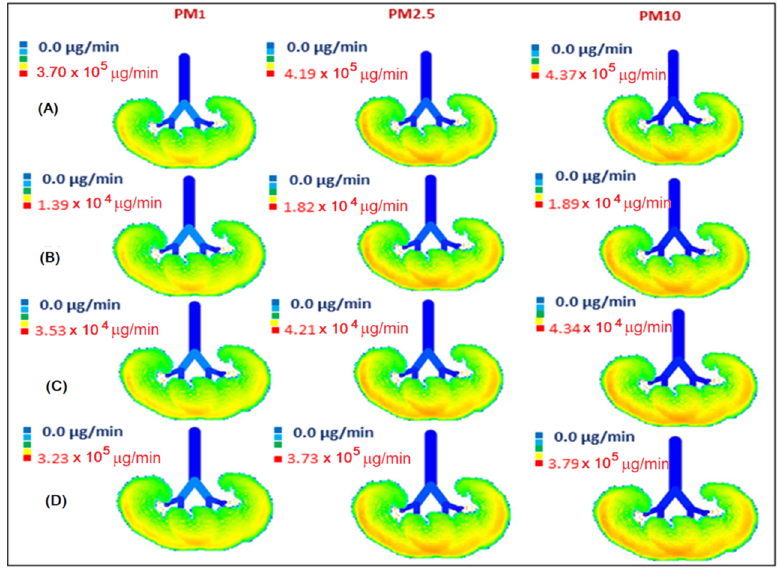
Figure 8. Visualization of size-segregated PM mass deposition rate in the human respiratory tract on the route FTMC1–FTMC2 during midday ( A ), from FTMC1–home during the evening ( B ), home–FTMC1 during morning rush hours ( C ), and in office FTMC1 ( D ).